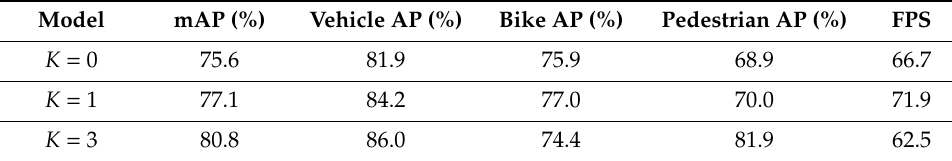
Table 6. Results of di ff erent settings of shielding computation.